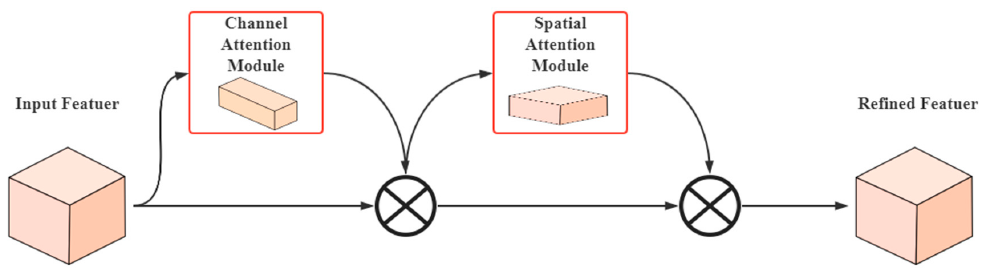
Figure 7. Convolutional block attention module.